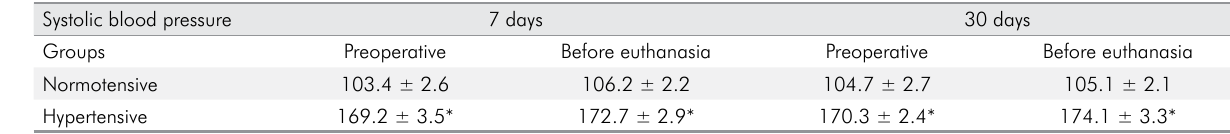
Table 1. Systolic blood pressure ± SD of normotensive and hypertensive rats.